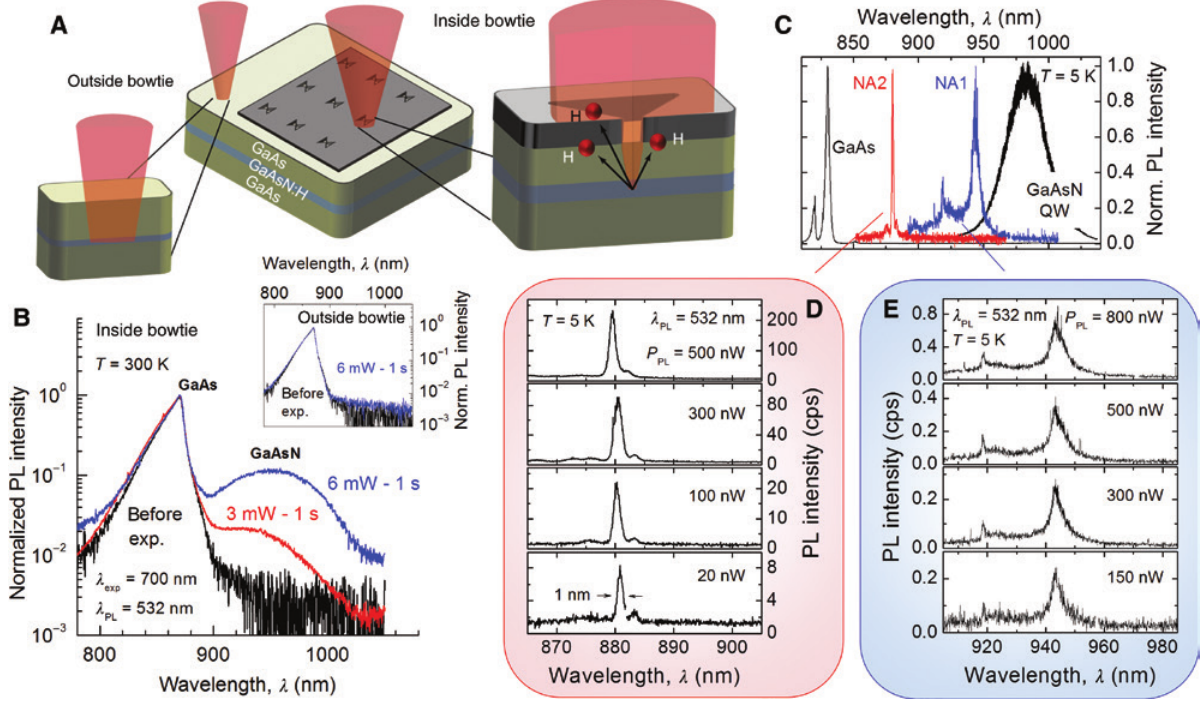
Figure 5: Plasmon-assisted H removal in dilute